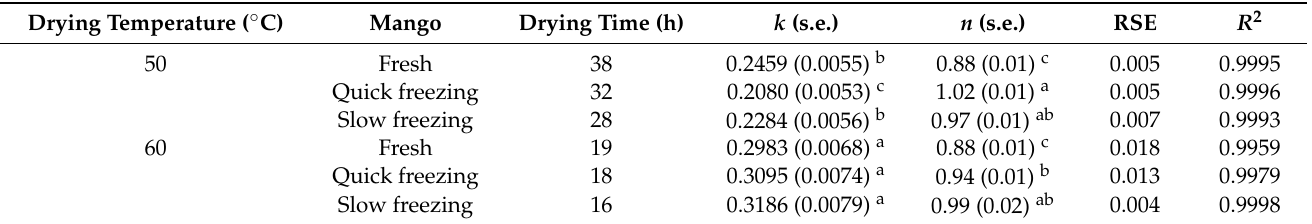
Table 2. Parameters ( k and n ) and their standard errors (s.e.) from Page’s model for describing drying behavior of mango slabs at 50 and 60 ◦ C.